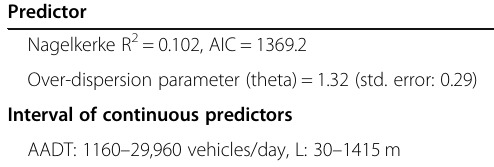
Table 2 Selected models for segments (Continued) Predictor Estimate Std.